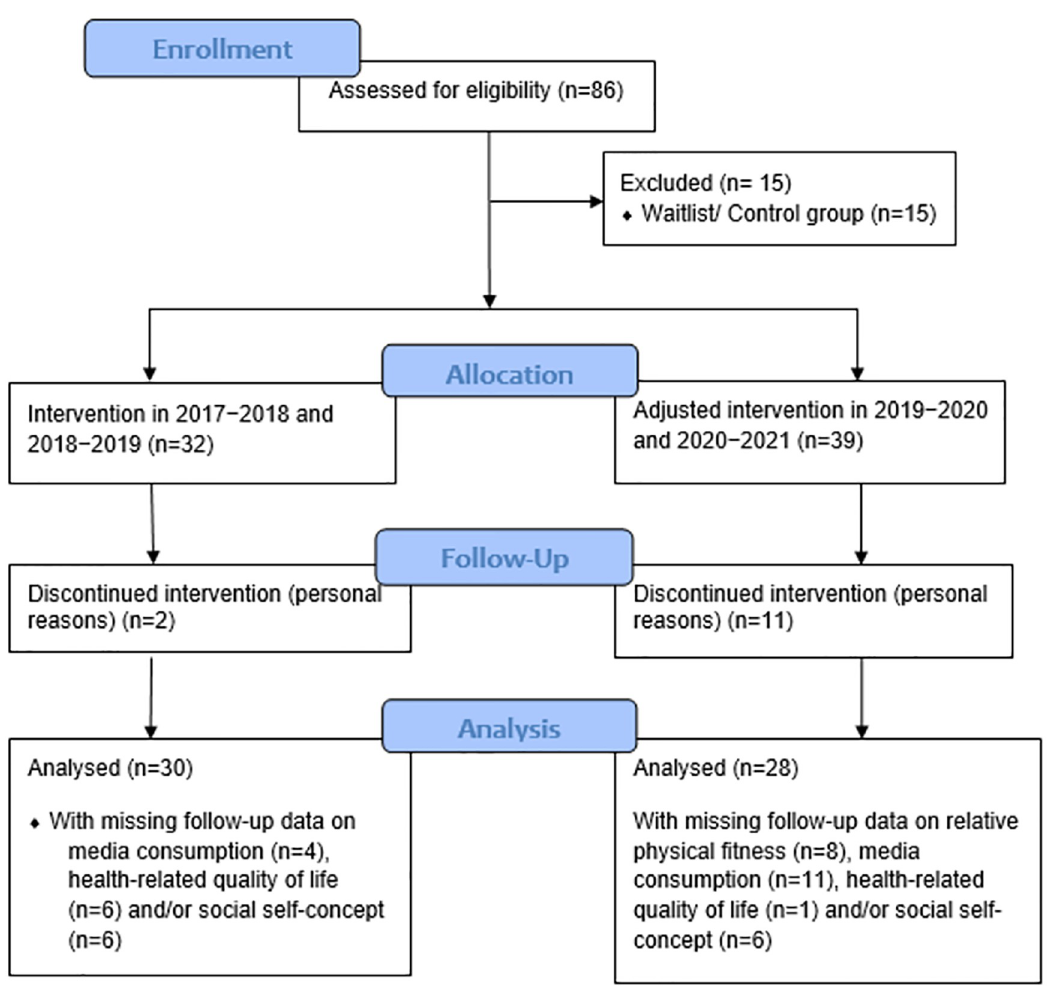
Fig 1. Flow diagram of number of participants in the